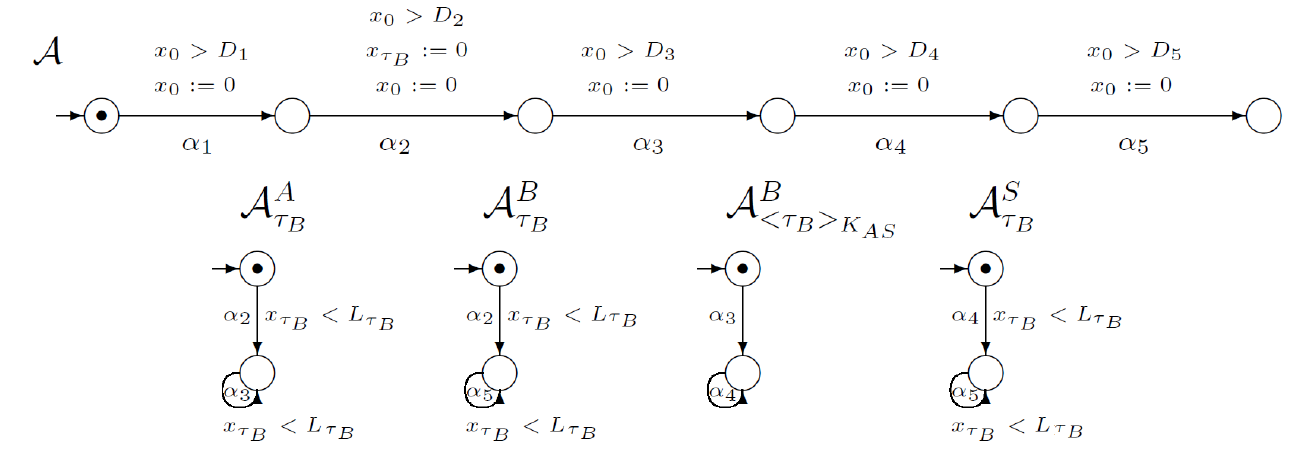
Figure 1. Network of synchronised timed automata for the WooLamPi protocol.